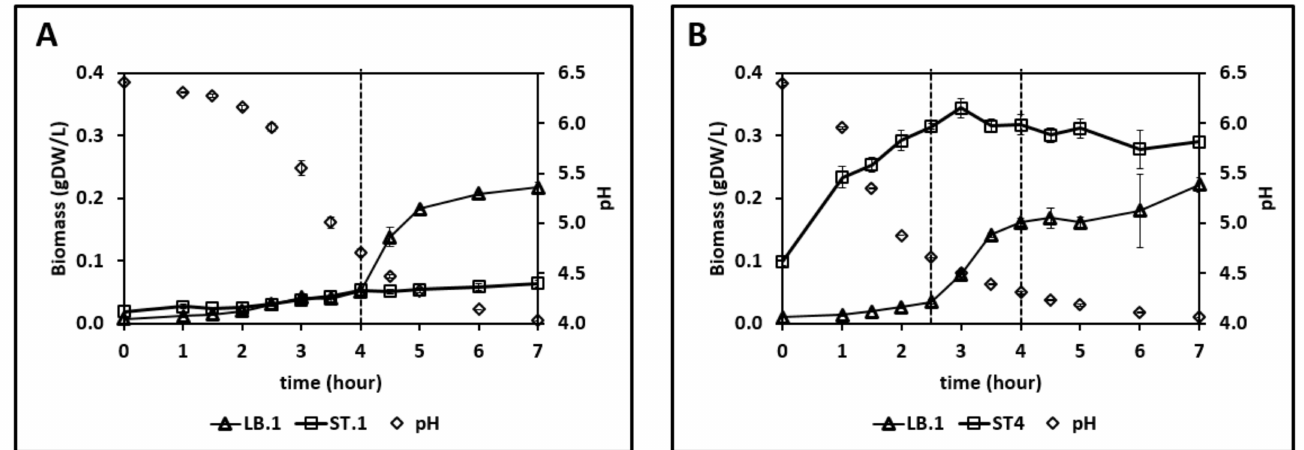
Figure 4. Strain-specific biomass profiles measured by flow cytometry and pH measurements in ( A ) LB.1–ST.1 (initial biomass fraction of 1:2 (LB:ST)) and ( B ) LB.1–ST.4 (initial biomass fraction 1:10 (LB:ST)) co-cultures in synthetic medium supplemented with casein